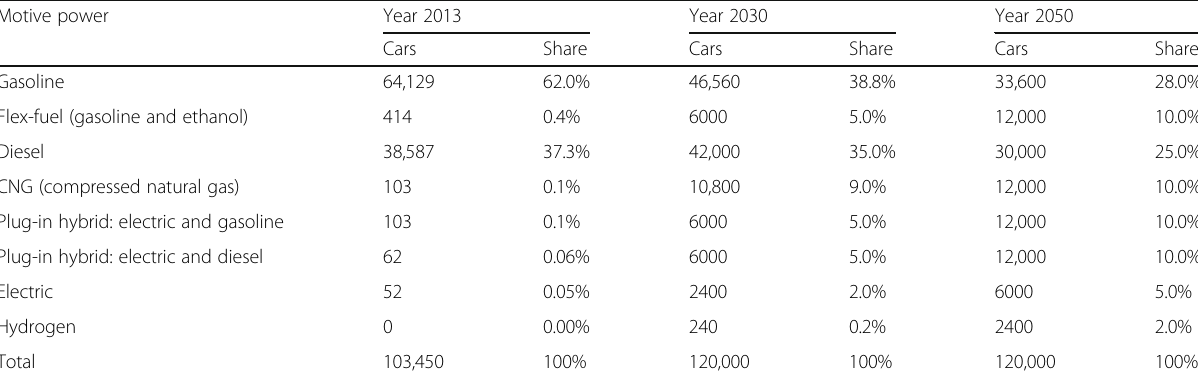
Table 2 New car sales by motive power in the reference scenario Motive